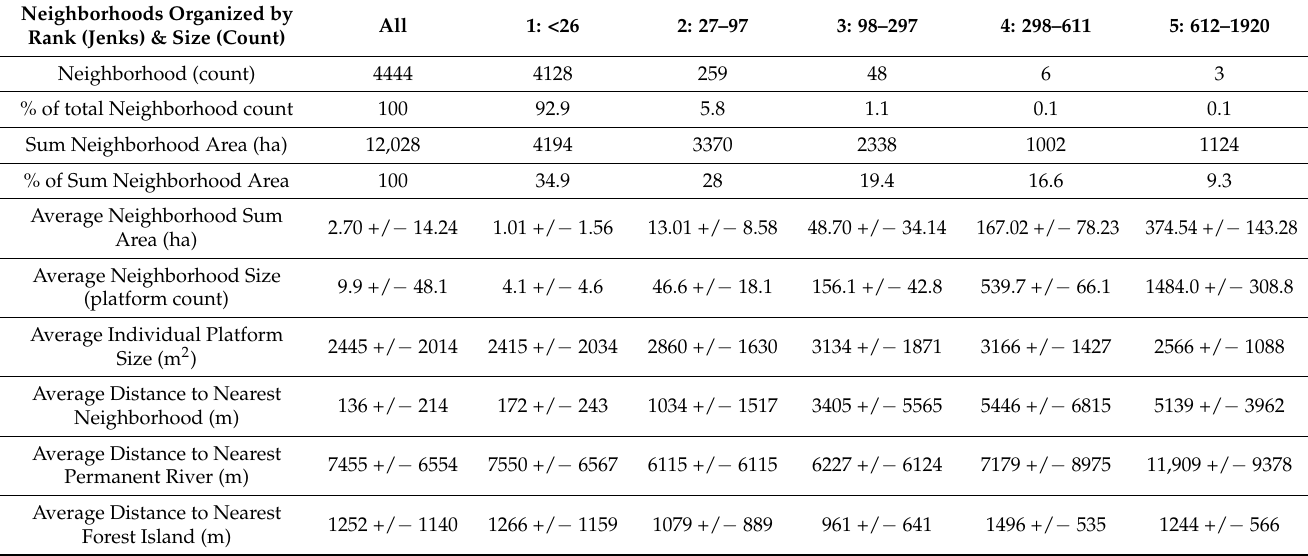
Table 1. Neighborhood platform counts are placed in a list then divide into 5 natural breaks (Natural Jenks) to examine the characteristics of neighborhoods of different sizes. The goal was to select cut-off values for large and small neighborhoods.